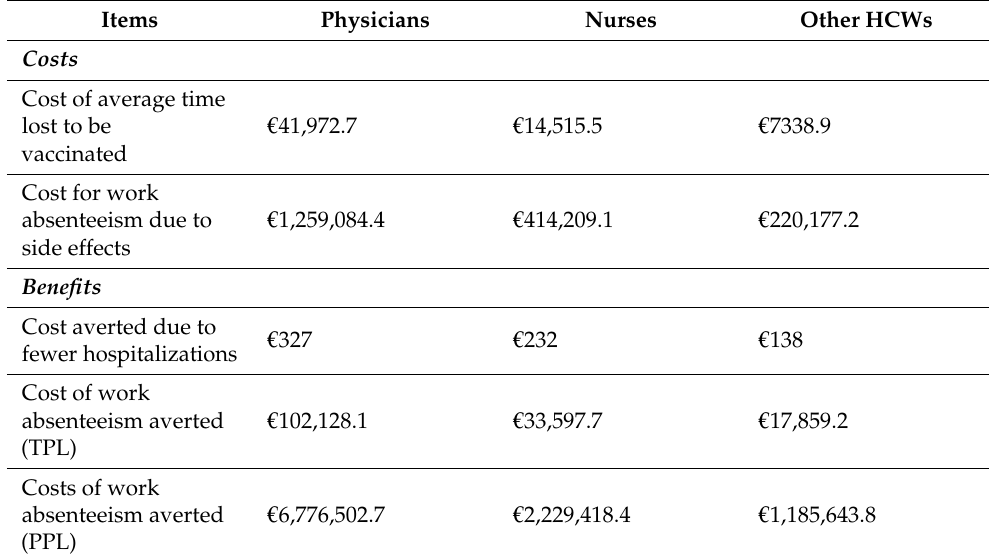
Table 1. Cost and benefits items according to the job